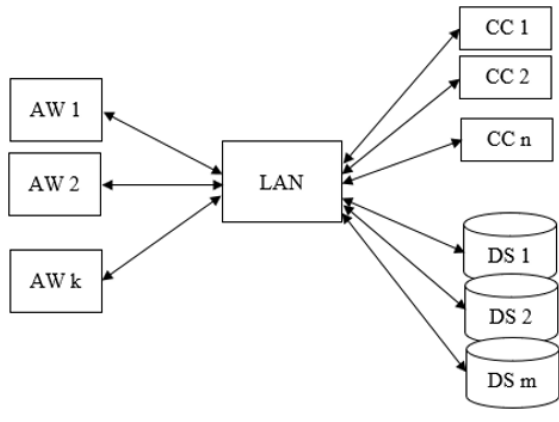
Fig. 1. Architecture scheme of interaction between